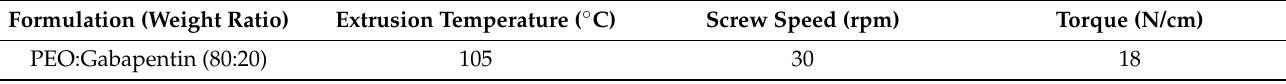
Table 6. HME parameters for developing